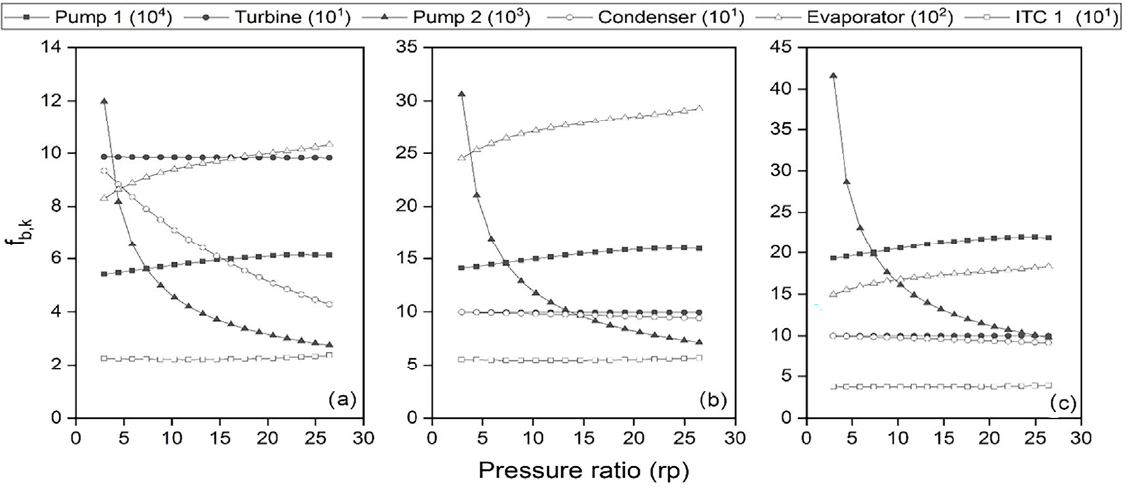
Figure 12. Exergo-environmental factor of the components using ( a ) steel, ( b ) copper, ( c ) aluminum as a base material.